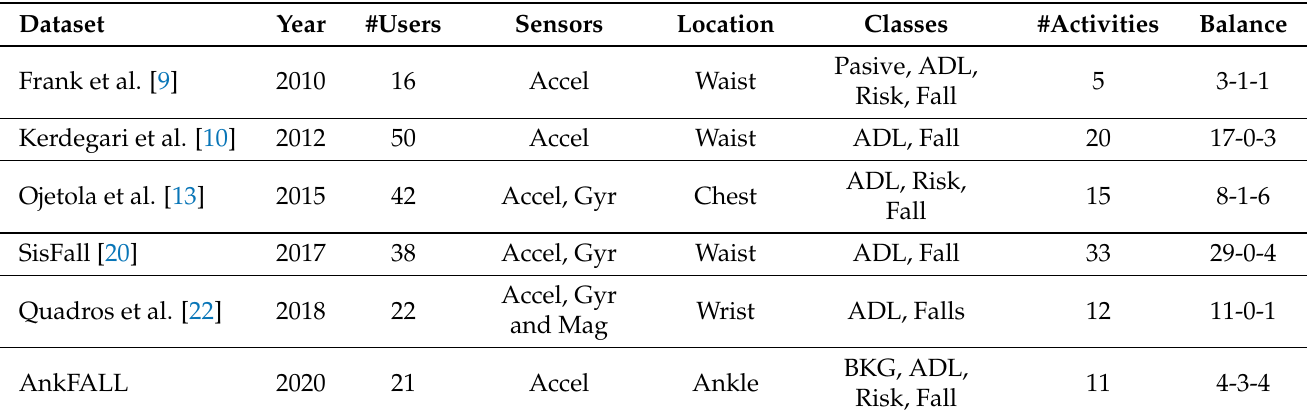
Figure 6. Resulting dataset. Table 4. Comparison between AnkFALL and the most similar datasets (from Table 1). The last column indicates the number of activities from each type (in order: activities of daily living (ADL), Risk,